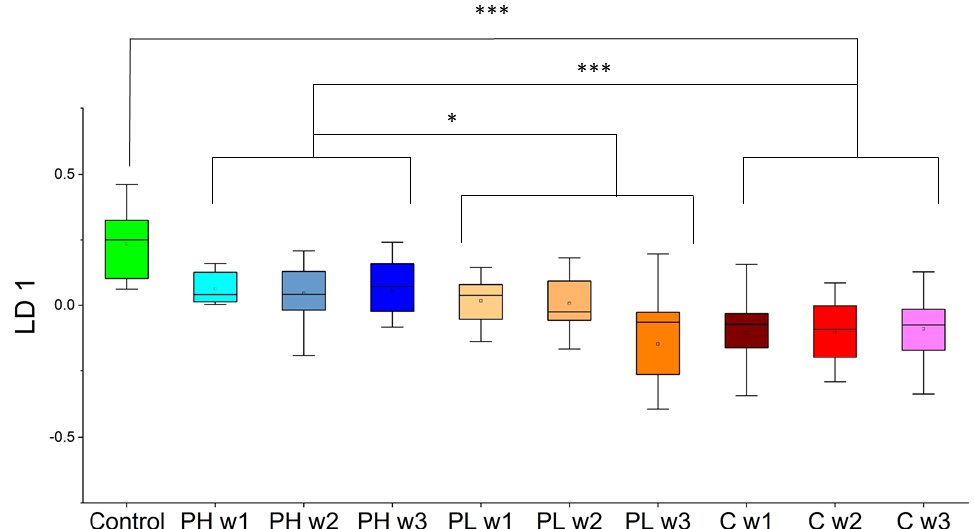
Figure 4. One-dimensional LDA plot where the model was trained to classify control from cancer and tested on pita high and pita low samples (PH = pitavastatin high, PL = pitavastatin low, C = cancer). * p -value < 0.05, *** p -value < 0.001.